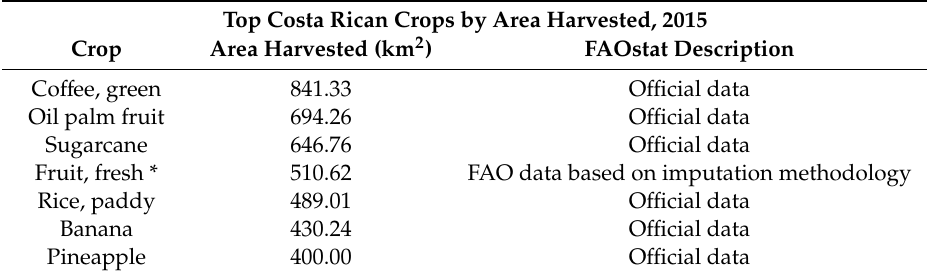
Table A1. FAO statistics of agricultural harvest in Costa Rica by area.